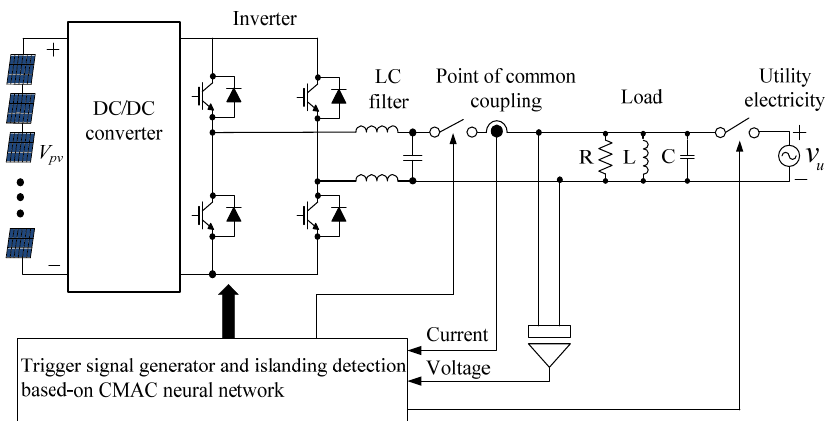
Figure 4. Architecture of the proposed islanding detection system.